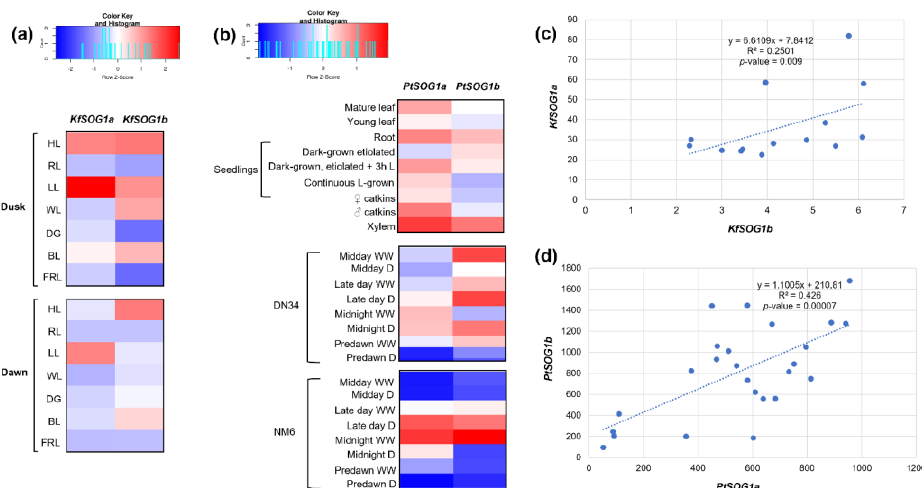
Figure 4. ( a ) Expression profiles of the KfSOG1a (Kaladp0062s0046) and KfSOG1b (Kaladp0073s0030) genes in K. fedtschenkoi . ( b ) Expression profiles of the PtSOG1a (Potri.008G116600) and PtSOG1b (Potri.010G129700) genes in P. trichocarpa . Data were collected from http://bar.utoronto.ca/, accessed on 19 March 2022 and heatmaps were generated using the Shinyheatmap (http://shinyheatmap.com, accessed on 19 March 2022). ( c ) Correlation analysis between KfSOG1a and KfSOG1b gene expression values. ( d ) Correlation analysis between PtSOG1a and PtSOG1b gene expression values.